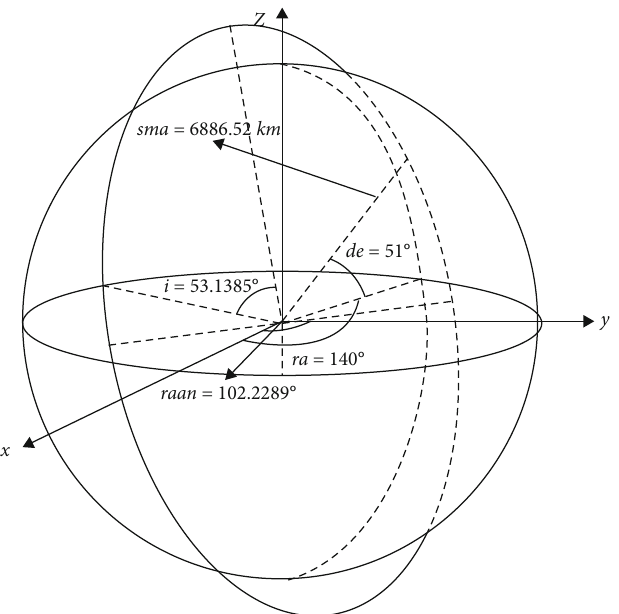
Figure 13: Impact point